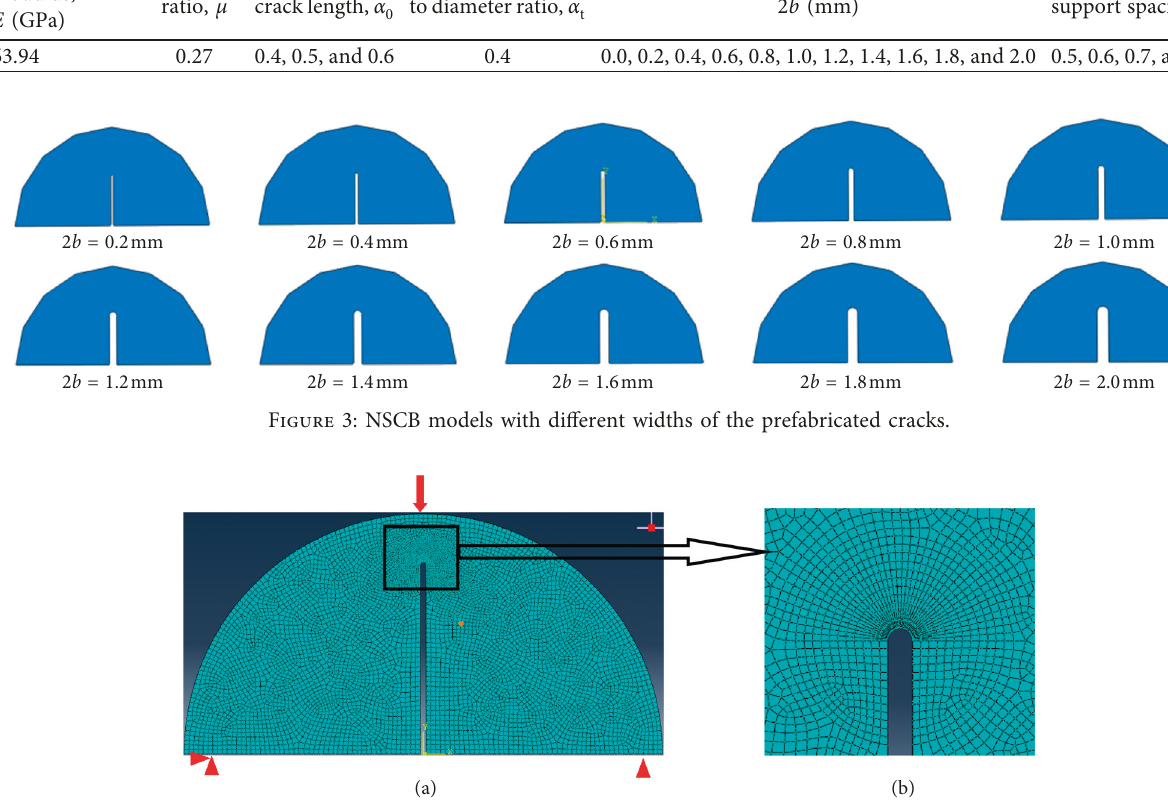
Figure 4: (a) NSCB specimen meshing. (b) Zoomed view of the mesh of the crack